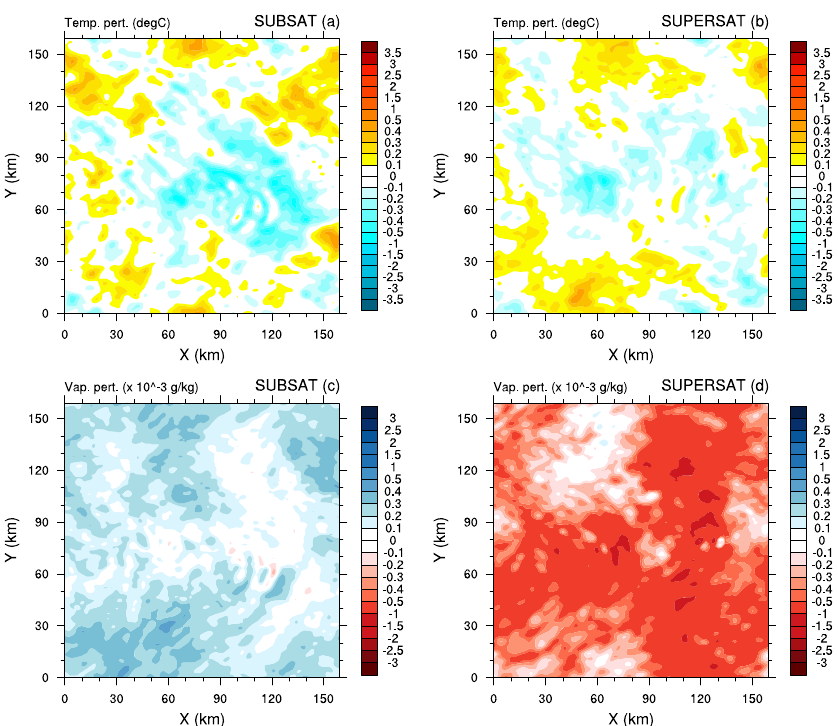
Fig. 7. SUBSAT and SUPERSAT horizontal cross-sections of (a, b) temperature perturbation and (c, d) water vapour perturbation, vertically- averaged for the lower TTL portion (355–385K) at